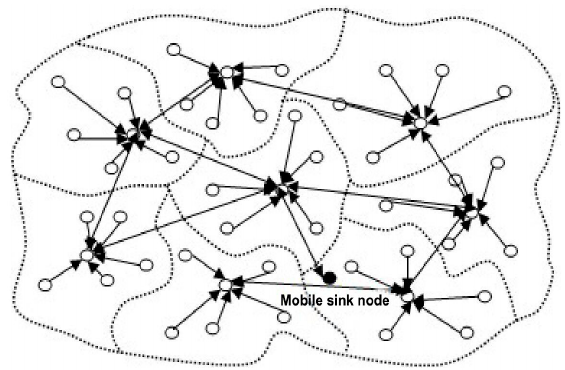
Figure 1. Data forwarding in an ELE.